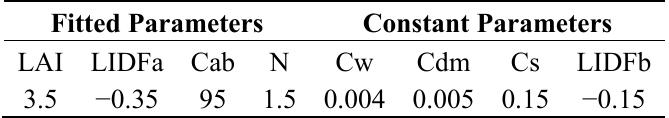
Table 3. Soil-Canopy-Observation of Photosynthesis and the Energy balance model (SCOPE) input parameters: Leaf Area Index (LAI), Leaf Inclination (LIDFa), Chorophyll A/B (Cab) content in µg/cm 2 , Leaf Thickness Parameter (N), Leaf water equivalent layer (Cw) in cm, Dry matter content (Cdm) in g/cm 2 , Senescent material fraction (Cs), Variation in leaf inclination (LIDFb). Default values were used for all other SCOPE input parameters.